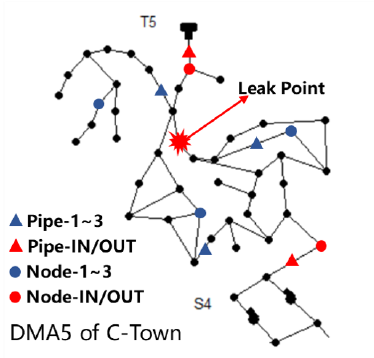
Figure 5. Topology of